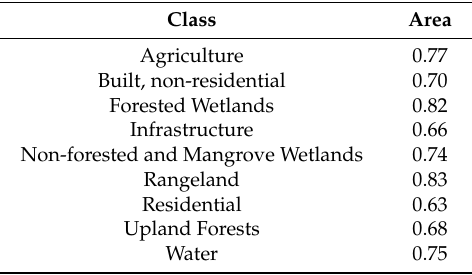
Table 5. Area values for receiver-operating characteristic (ROC) curves to evaluate binomial logistic regression models of driving factors for each LULC